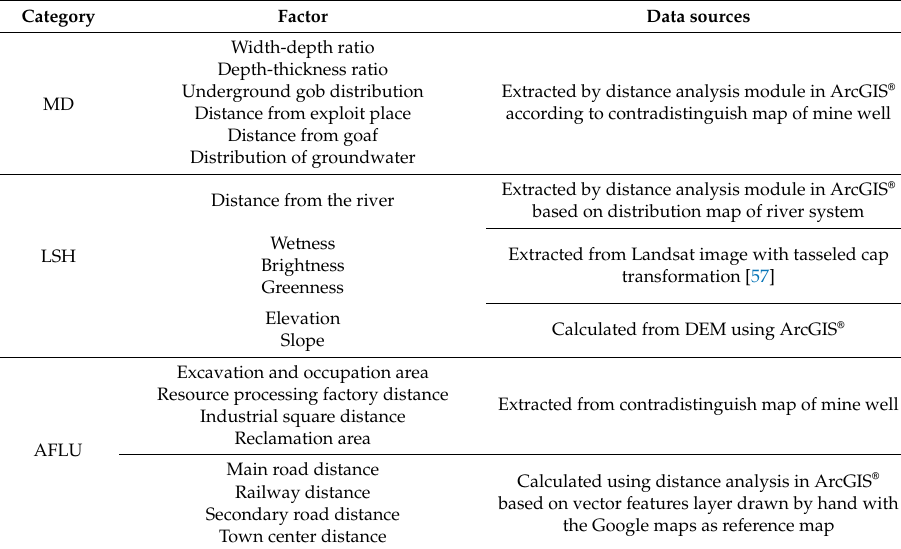
Table 2. Driving factors for the calculation of